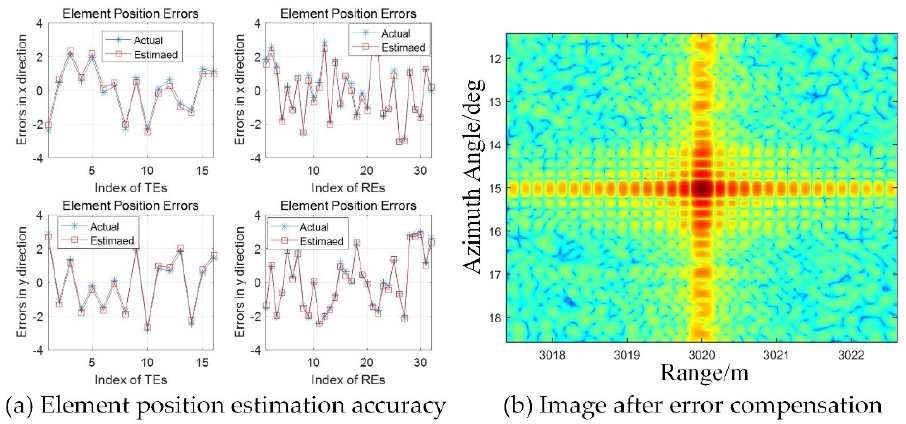
Figure 7. BP image result after element position error estimation and compensation ( a ) element position estimation accuracy; ( b ) image after error